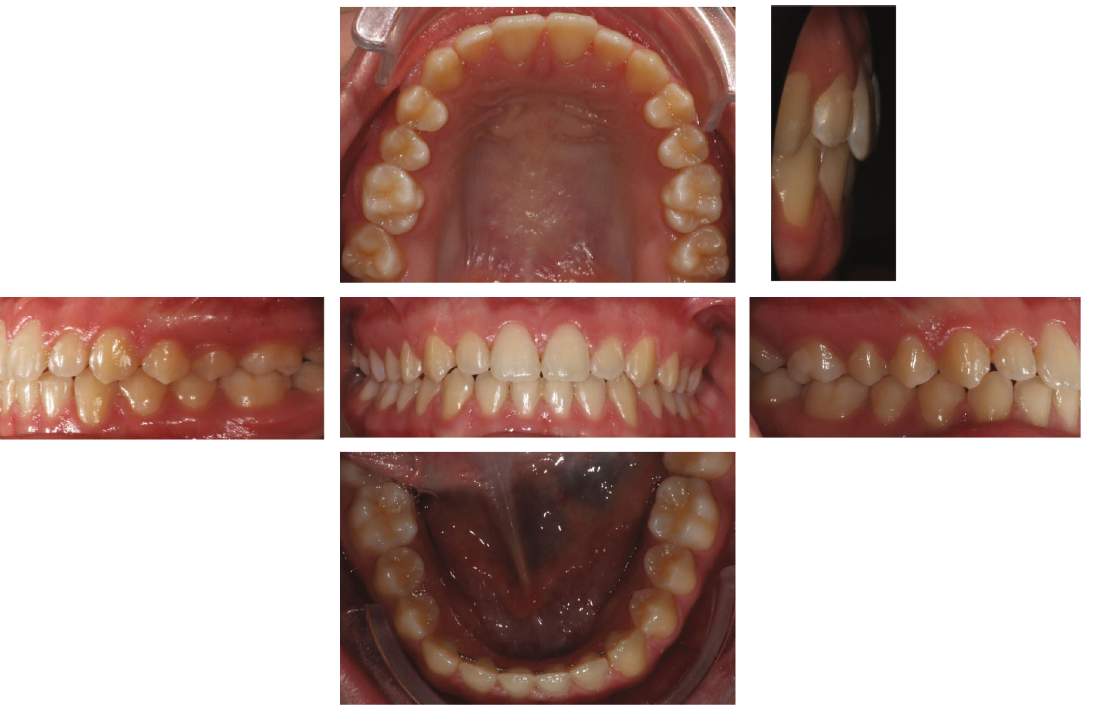
Figure 12: Final intraoral photographs.